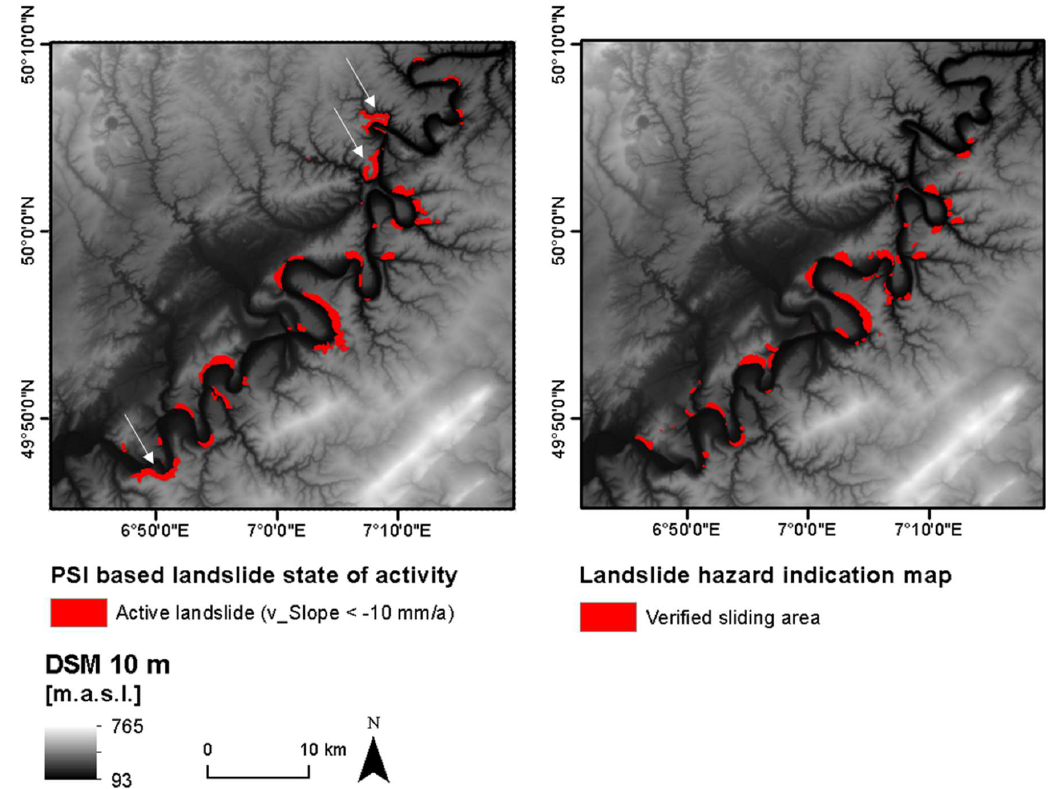
Figure 6. Verification of the classification result regarding “active landslides” ( A ) with “verified sliding areas” from the landslide hazard indication map ( B ). A DEM © GeoBasis-DE/BKG 2018 [19] serves as background.